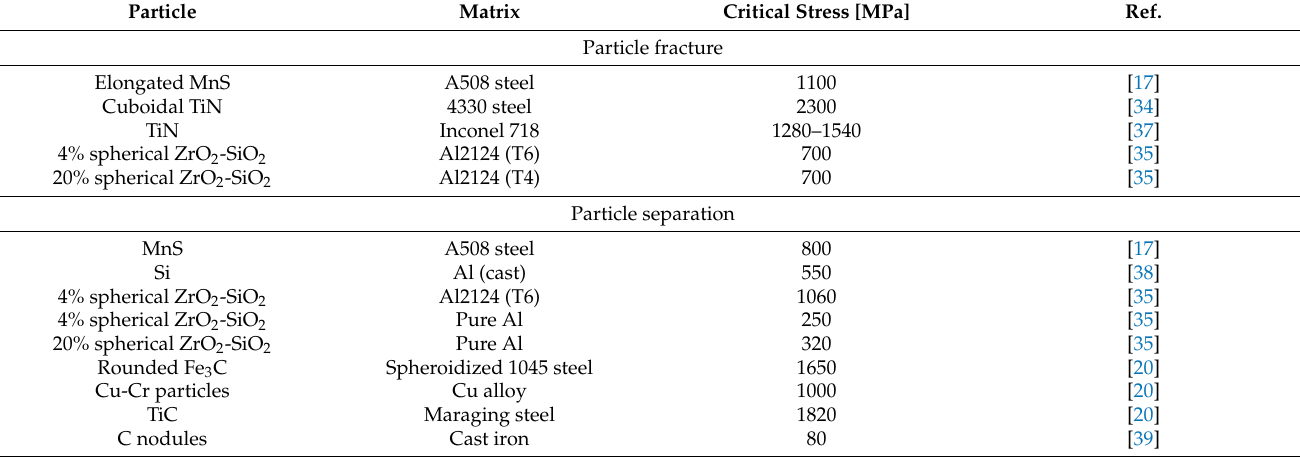
Table 1. Critical values of void nucleation stresses reported in the literature, from [36].